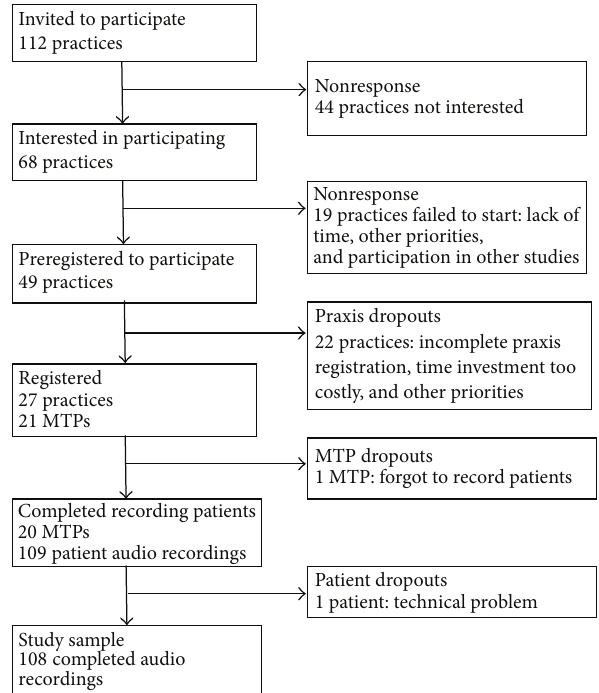
Figure 1: Flowchart of manual physical therapy practices and par- ticipant manual physical therapists’ (MTPs’) responses and reasons for nonresponse and